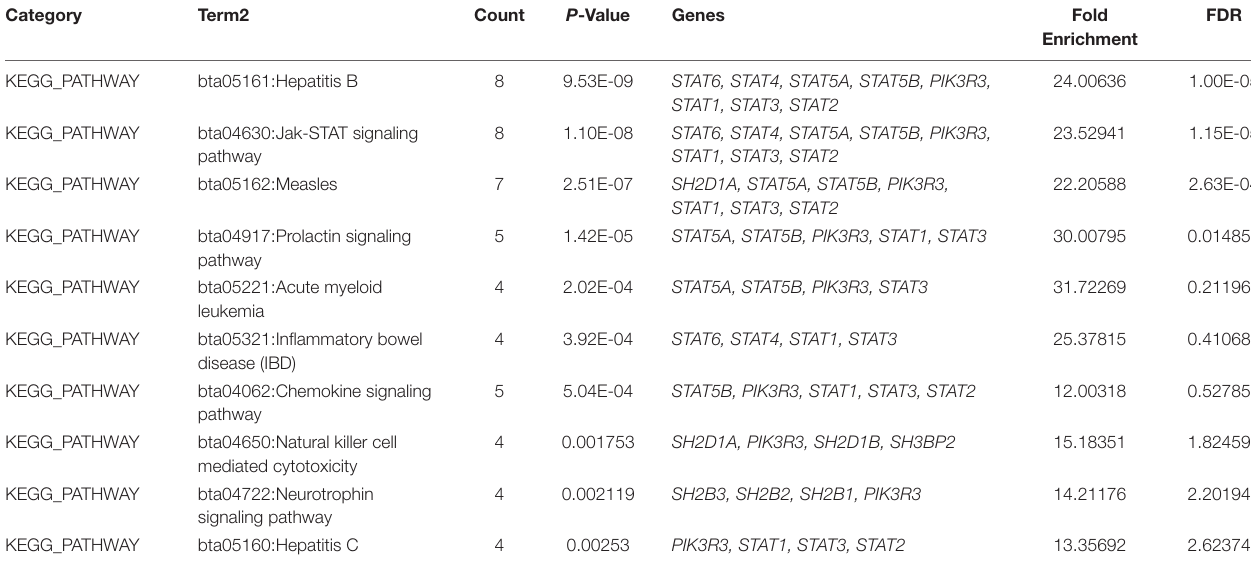
MF, molecular functions; BP, biological processes, CC, cellular component. TABLE 5 | Top 10 of KEGG pathway